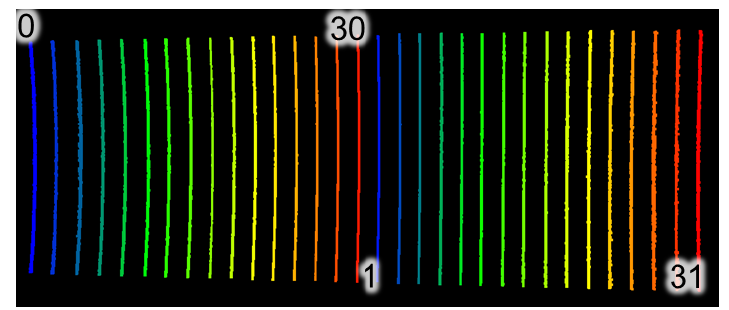
Figure 5. Velodyne ® HDL–32E raw observations as points representing scan lines from all 32 individual channels (even numbers 0 through 30 from left to right, followed by odd numbers 1 through 31 from left to right).